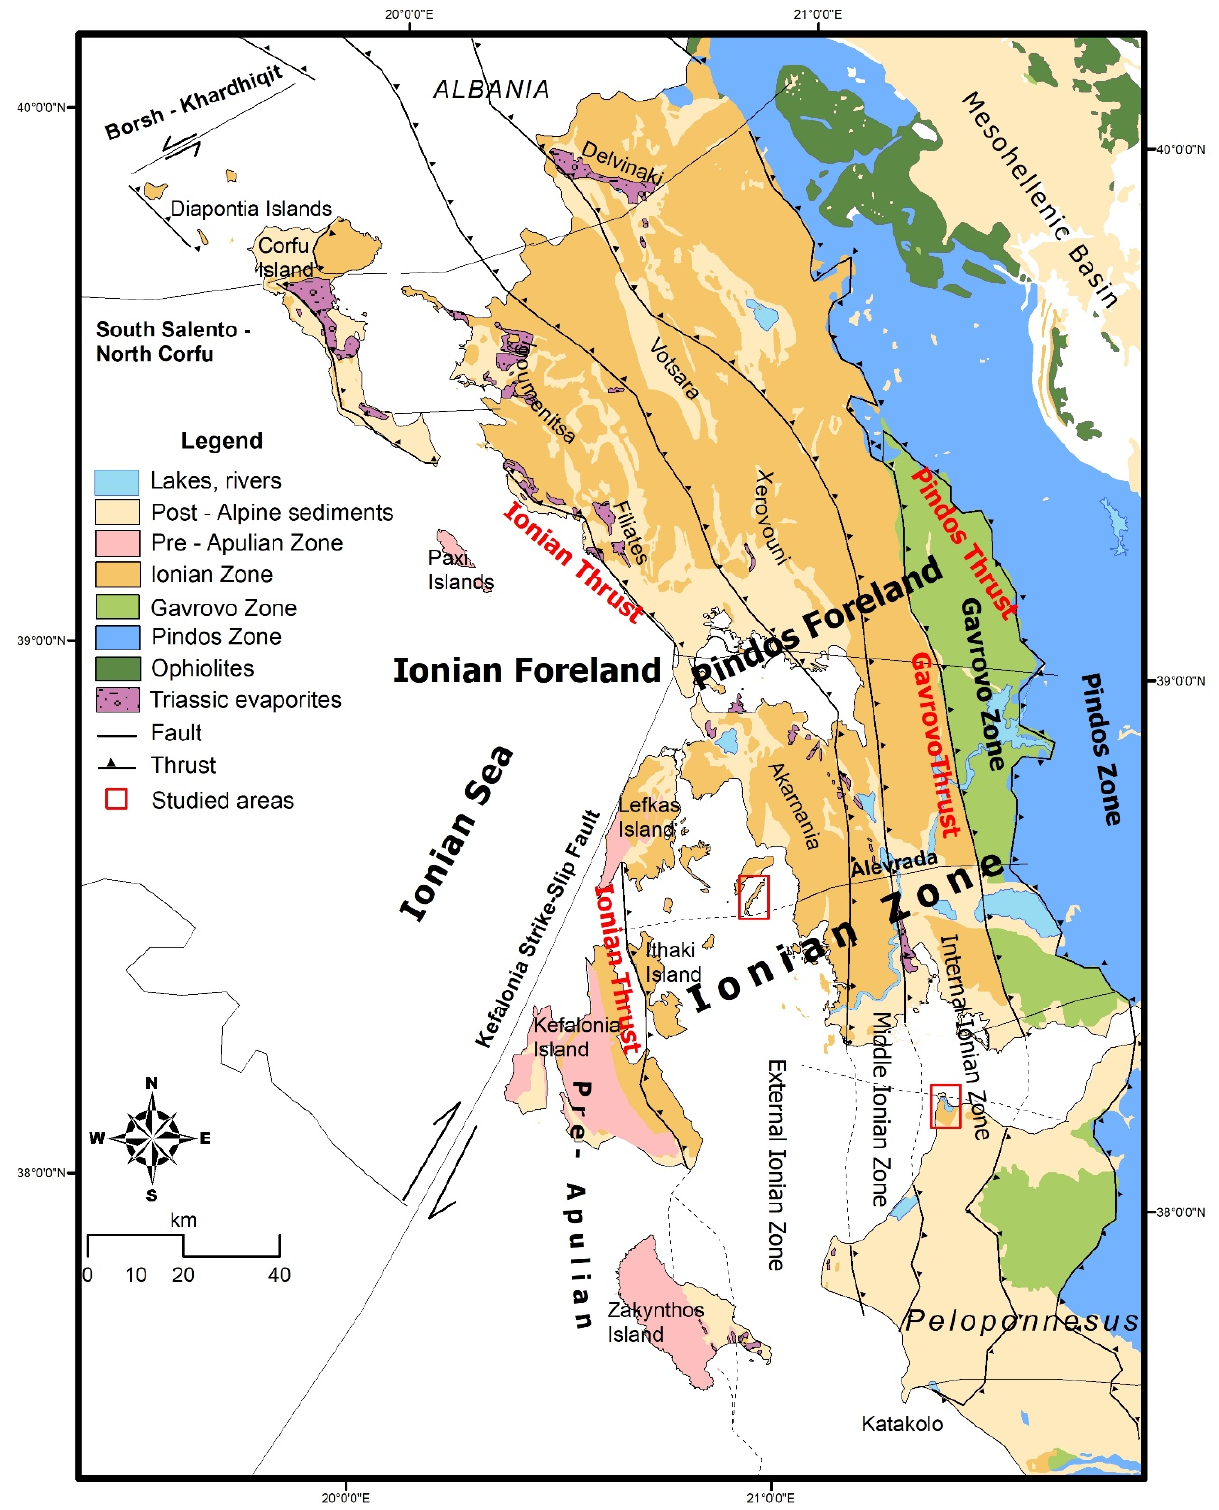
Figure 1. Geological map of the external Hellenides in NW Greece illustrating the principal tectonostratigraphic zones: Pindos, Gavrovo, Ionian, and Pre-Apulian Zones (modified from [12]). Red boxes show the studied areas of Kastos Island, in the external Ionian zone, and Araxos peninsula (NW Peloponnesus), in the internal Ionian zone.